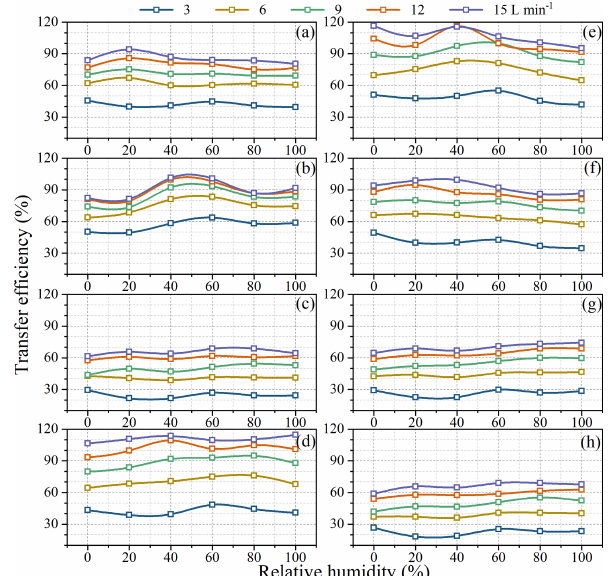
Figure 6. Influence of relative humidity and flow rates on trans- fer efficiencies of BVOCs: (a) acetonitrile, (b) acrylonitrile, (c) acrolein, (d) acetone, (e) isoprene, (f) methylacrolein, (g) α - pinene, and (h) β